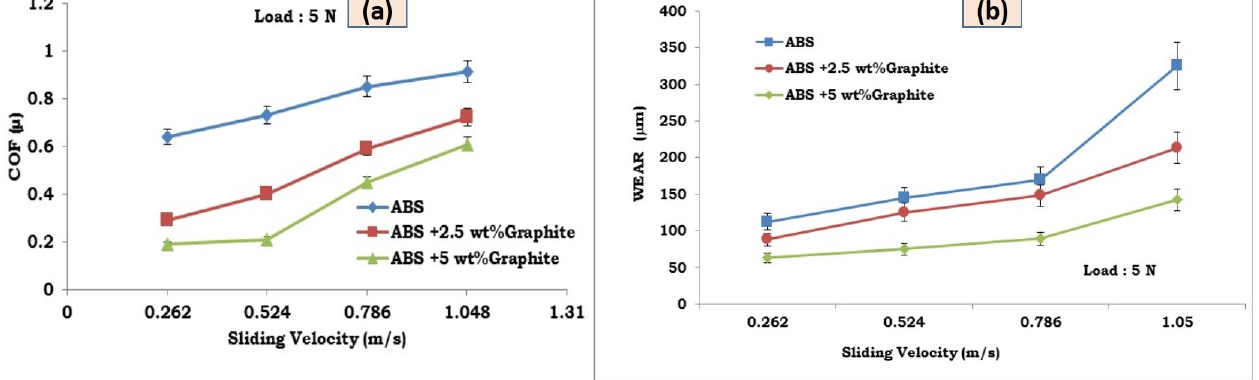
Figure 5. ( a , b ) Graphical representation of effect of sliding on coefficient of friction and wear loss for unfilled and graphite filled ABS parts developed by FDM process.